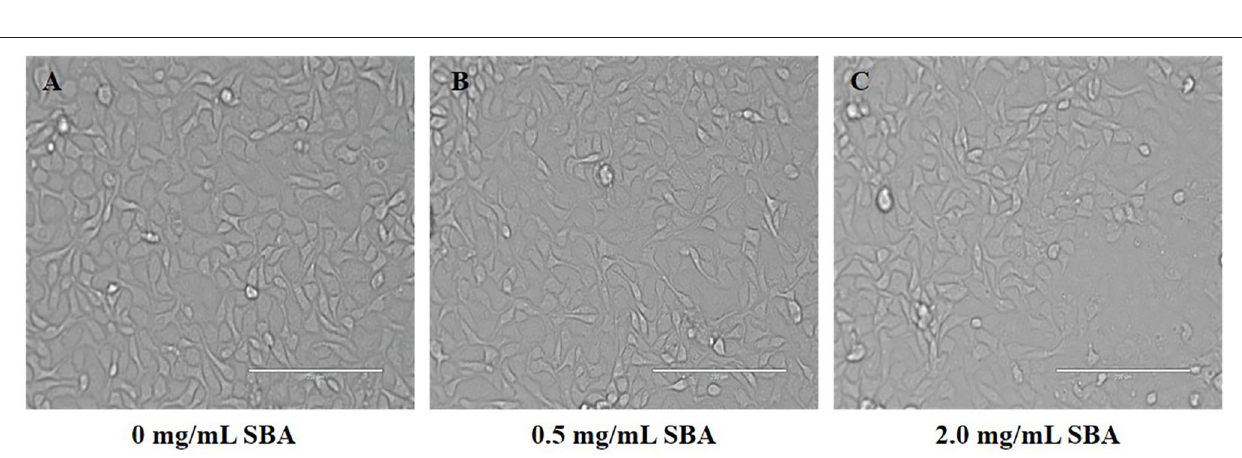
FIGURE 4 | Effect of different SBA concentrations on IPEC-J2 cell morphology (200 × ). IPEC-J2 was cultured with 0.0, 0.5, or 2.0 mg/mL SBA for 24h. Cell morphology was observed in different treatments by contrast microscopy at 200 × magnifications. (A) Control, 0.0 mg/mL SBA treatment; (B) 0.5 mg/mL SBA treatment; and (C) 2.0 mg/mL SBA